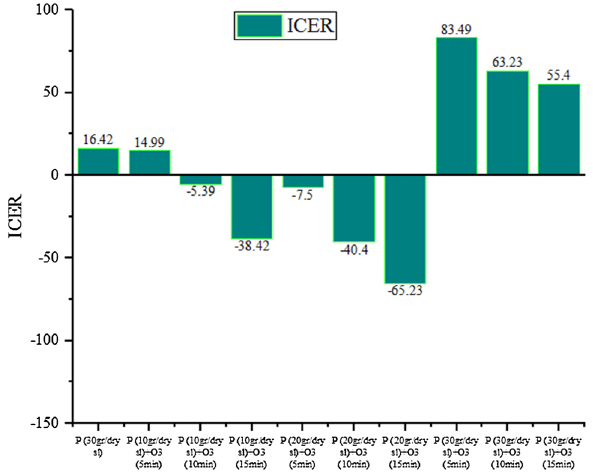
Fig. 8 Cost-effectiveness of each